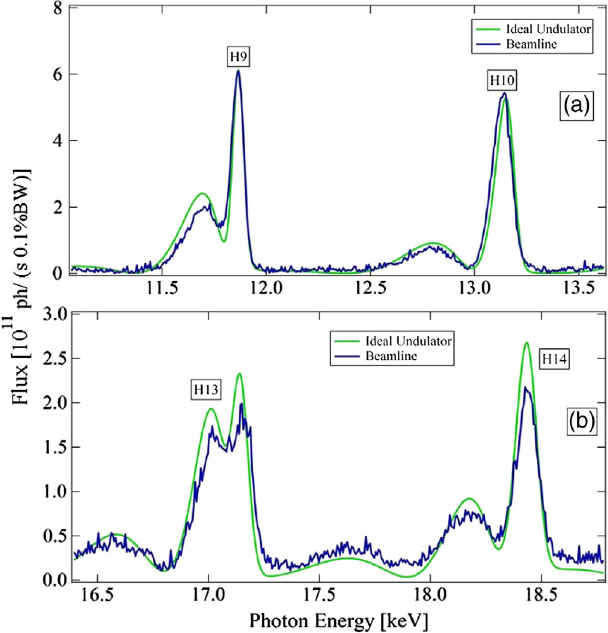
FIG. 22. (Green) spectra computed by an ideal undulator using SRWE with beam characteristics as Fig. 21. (Blue) spectra from the beam line normalized to H9 of ideal